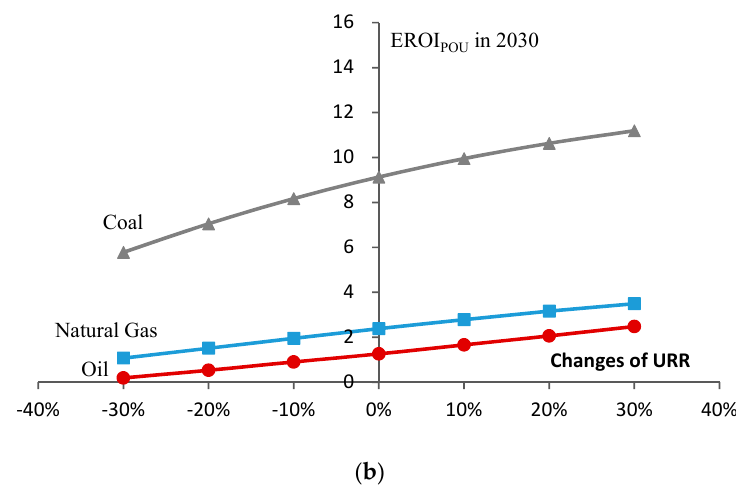
Figure 10. Sensitivity analysis of URR and energy regarding the EROI POU of coal, oil and natural gas. Portion ( a ) indicates that the EROI POU of oil and natural gas are sensitive to energy price changes; portion ( b ) indicates that the EROI POU of coal, oil and natural gas is sensitive to URR changes. Figure 10a indicates that the EROI POU of oil and natural gas is sensitive to energy price increases, but EROI POU of coal is not. The reason for this situation is that China imported little coal during 1980– 2015 because of abundant reserves. Figure 10b indicates that the EROI POU of coal, oil and natural gas is sensitive to URR increases.